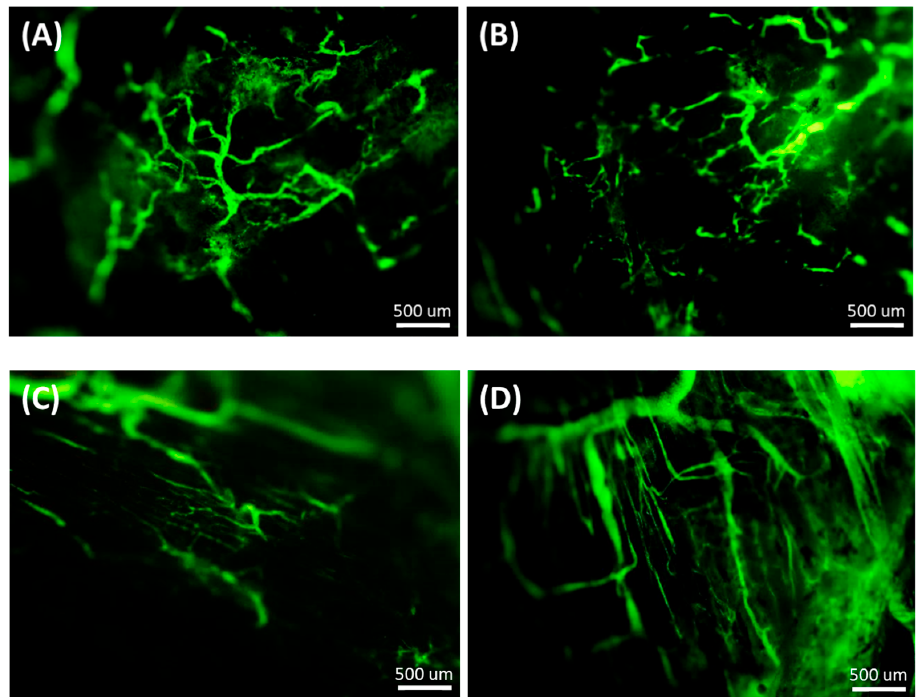
Figure 8. Normalization of tumor vasculature after treatment with normal saline ( A ), SN-38 micelles ( B ), Sunitinib micelles ( C ) and SN-38/Sunitinib micelles ( D ) (Scale bar = 500 µ m) at 24 h after injection. Dextran staining was used to assess tumor vasculature.